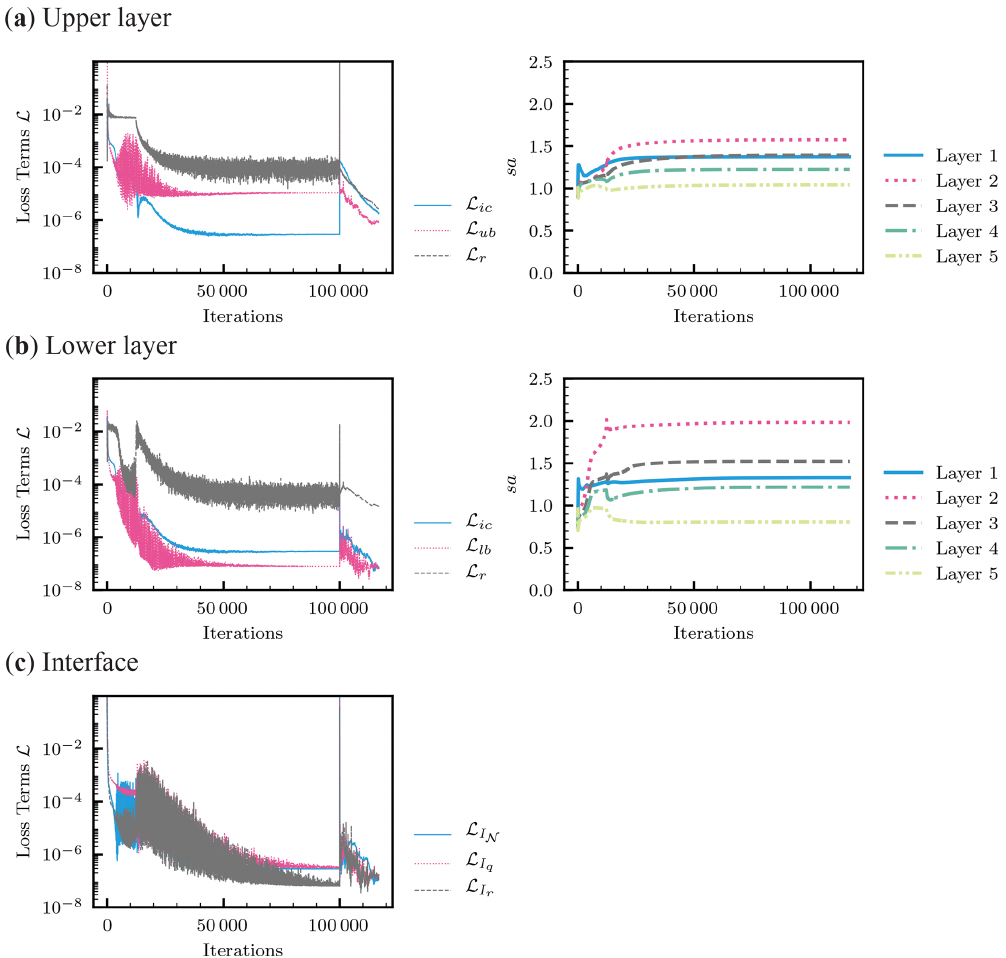
Figure 12. Heterogeneous soil. (a) The evolution of the loss terms in the loss function (left column) and adaptive parameters sa for the layer-wise locally adaptive activation function (Eq. 9) for each hidden layer (right column) during the Adam algorithm (100000 iterations) and the following L-BFGS-B training for the neural network for the upper layer. Here, Layer 1 is next to the input layer. (b) The same for the lower layer. (c) The evolution of the loss terms for the interface